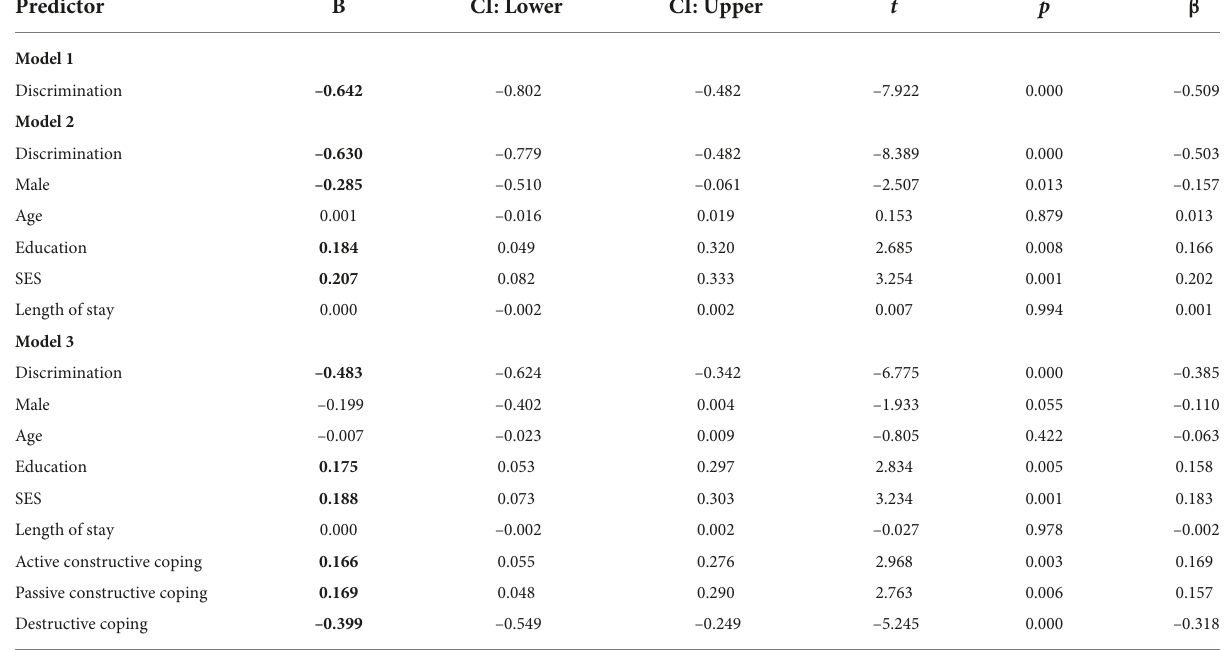
TABLE 2 Serial models of discrimination predicting general wellbeing.